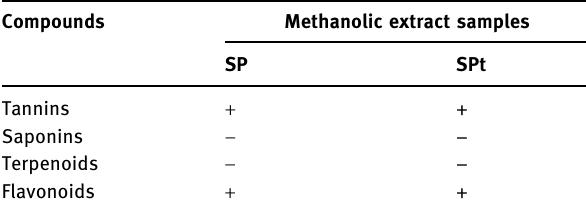
Table 5: Qualitative analysis of phytochemical constituents of SP and SPt for 21 days of culture Compounds